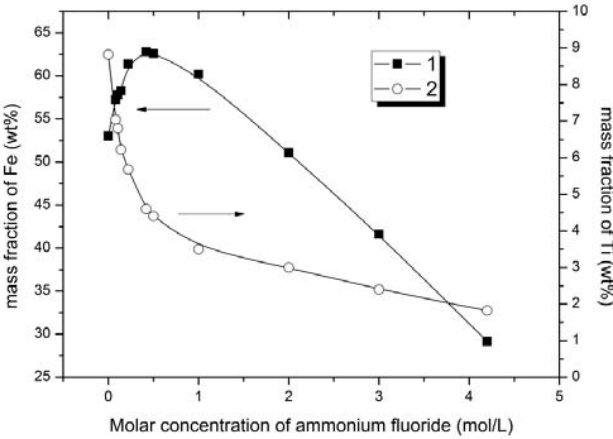
Figure 4. Iron and titanium content in solid phase vs. concentration of ammonium fluoride. (1)—Mass fraction of Fe in solid phase (wt %); (2)—Mass fraction of Ti in solid phase (wt %).